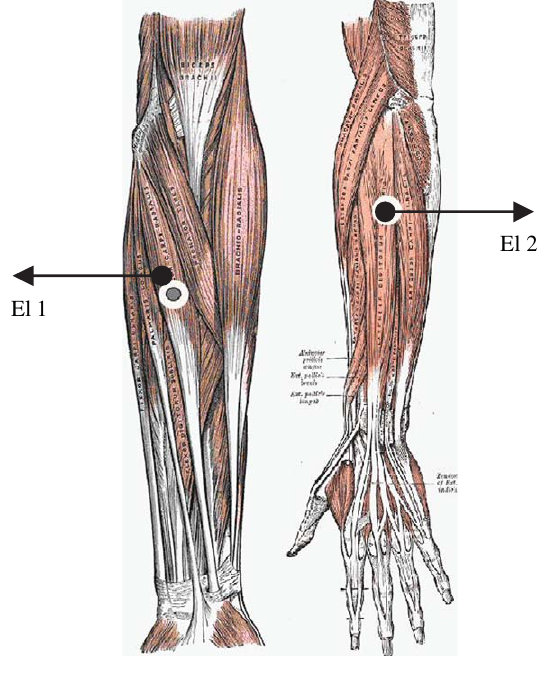
Fig. 4. The position of the two